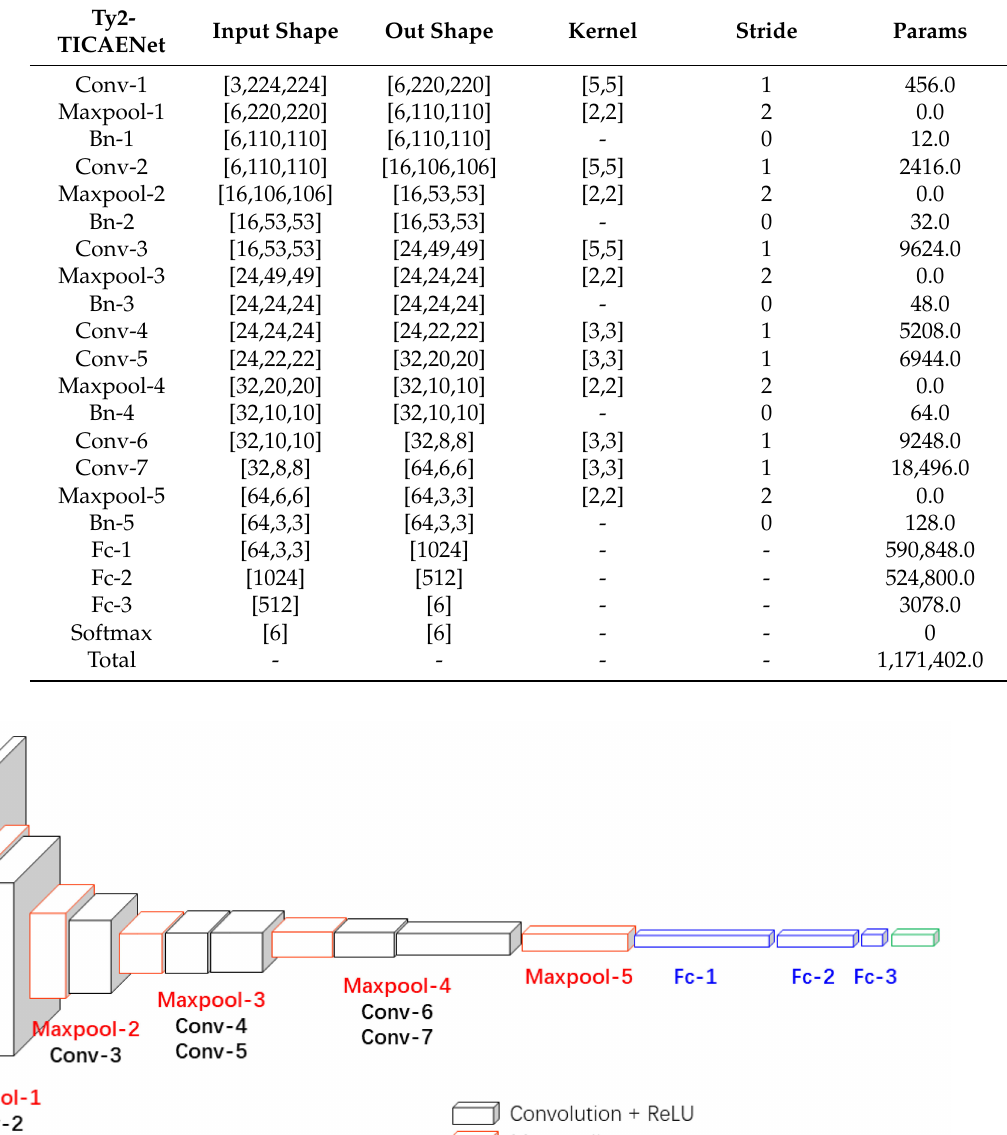
Table 4. Network structure of the Ty2-TICAENet model.